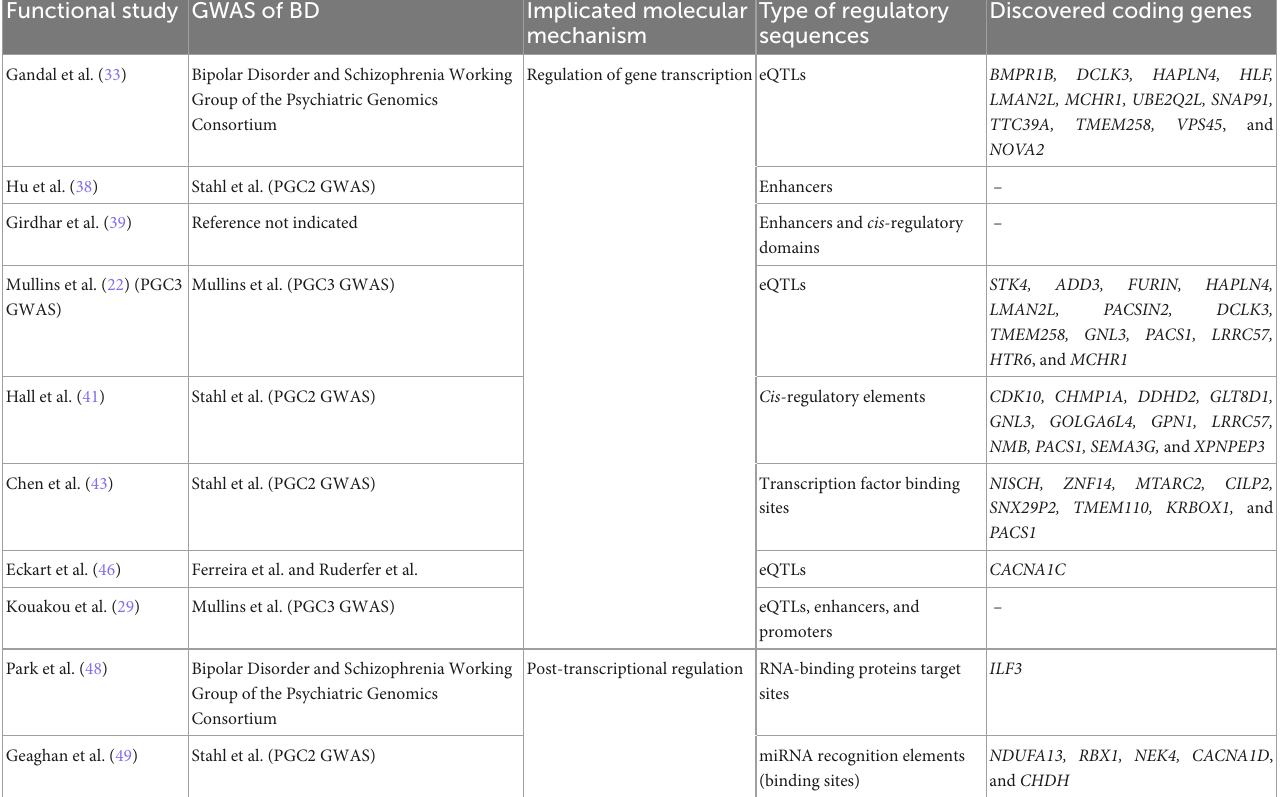
TABLE 2 The outline of functional studies that revealed alterations in gene transcription and in post-transcriptional regulation linked to common genetic variants associated with bipolar disorder (BD). Functional study GWAS of